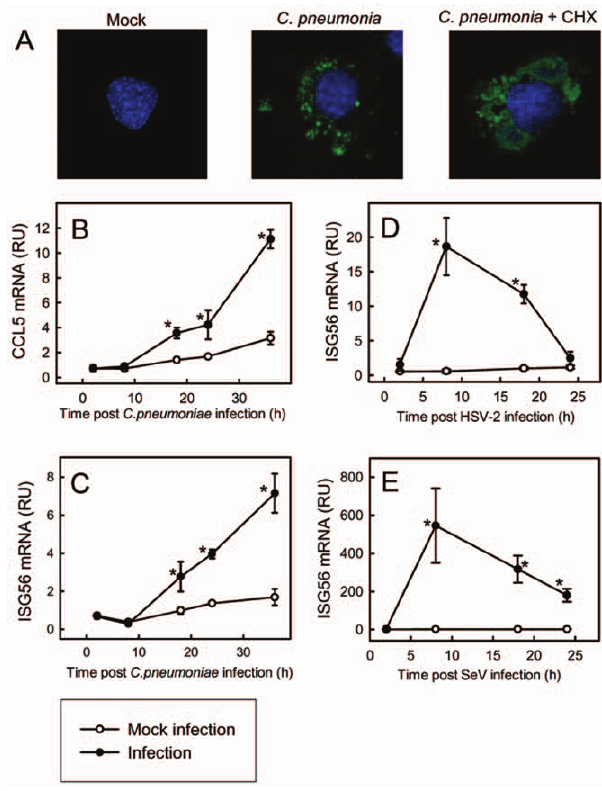
Figure 1. Chlamydia pneumoniae induces expression of ISGs with a delayed kinetics compared to viruses. (A) MEF cells were infected with C. pneumoniae (5 UFU/cell) in presence or absence of cycloheximide (CHX, 1 m g/ml). 36 hrs post infection, the cells were fixed and stained with an antibody against chlamydial LPS and fluorescence/ Nomaski images were obtained. (B–E) MEFs were infected with (B–C) C. pneumonia , MOI 5(D) HSV-2, MOI 1, or (E) SeV, MOI 1 for the indicated time intervals. Total RNA was harvested and mRNA levels of ISG56 and CCL5 were determined by real-time PCR and normalized to b -actin. The data are presented as means of triplicate cultures + / 2 st.dev. Similar results were obtained in 2–5 independent experiments. RU, relative units. Infection-induced gene expression significantly above the expression induced by mock infection at the same tine point (p , 0.05) is marked with an asterisk,